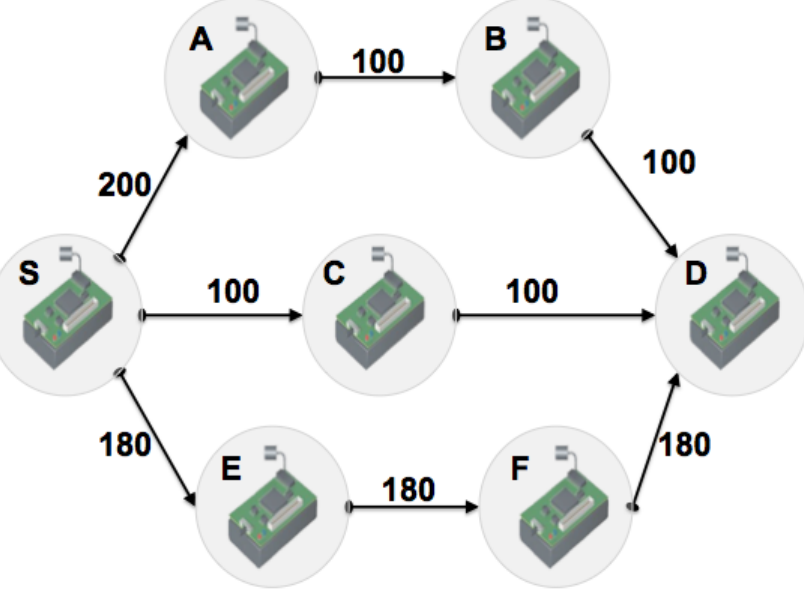
Figure 1. End-to-end link quality